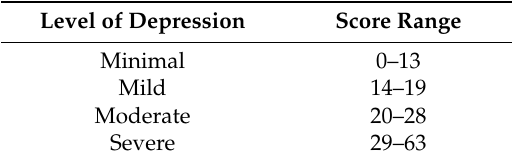
Table 1. Levels of depression defined by the Beck Depression Inventory (BDI) version II (BDI-II). questionnaire.